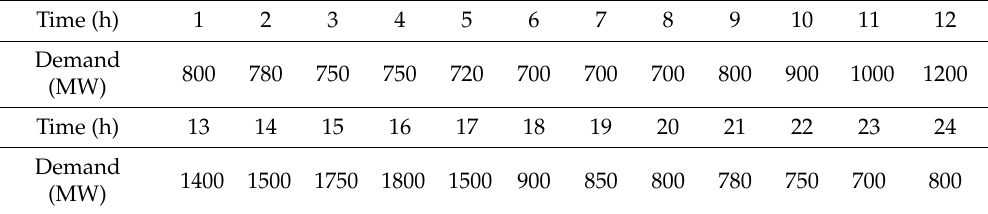
Table 2. Demand forecasting over 24